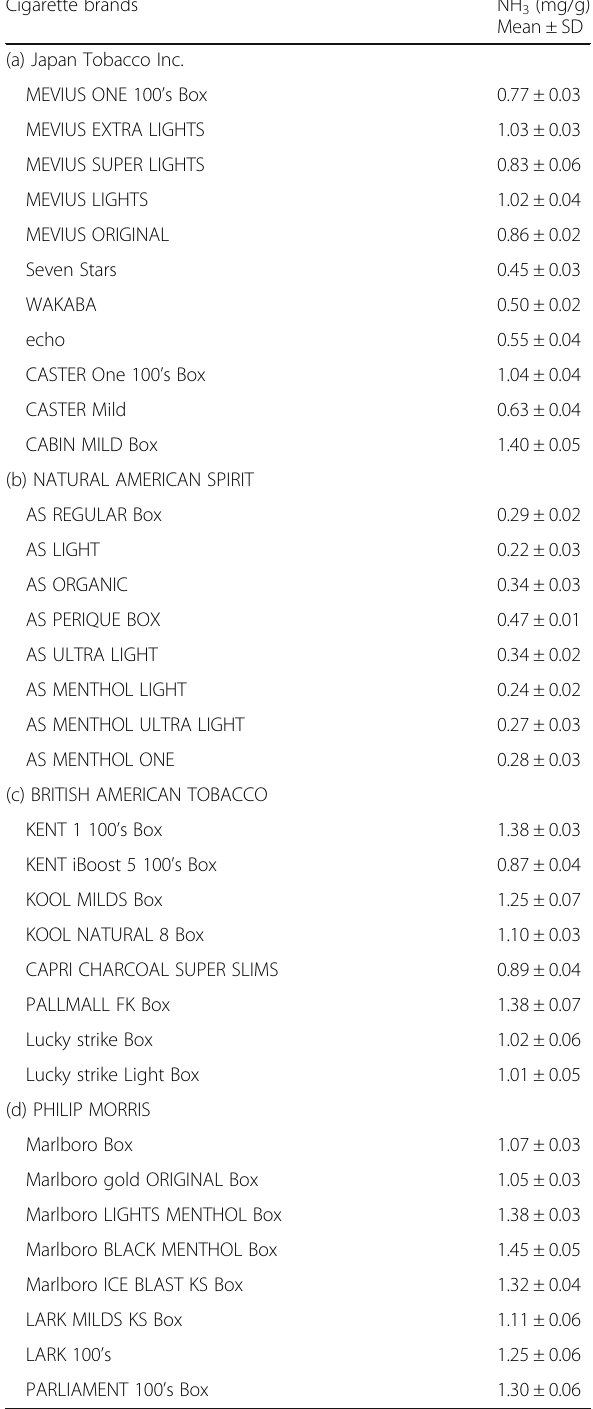
Table 2 Ammonia levels in tobacco filler extracted